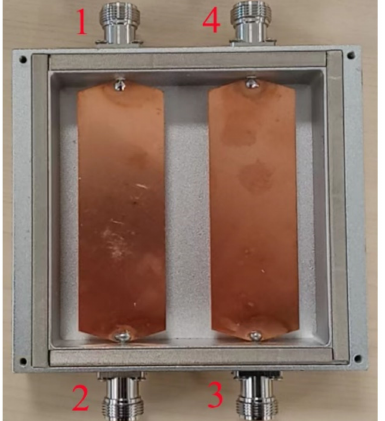
Figure 14. IC-Stripline cell based on image theory. The cover of the cell is removed.